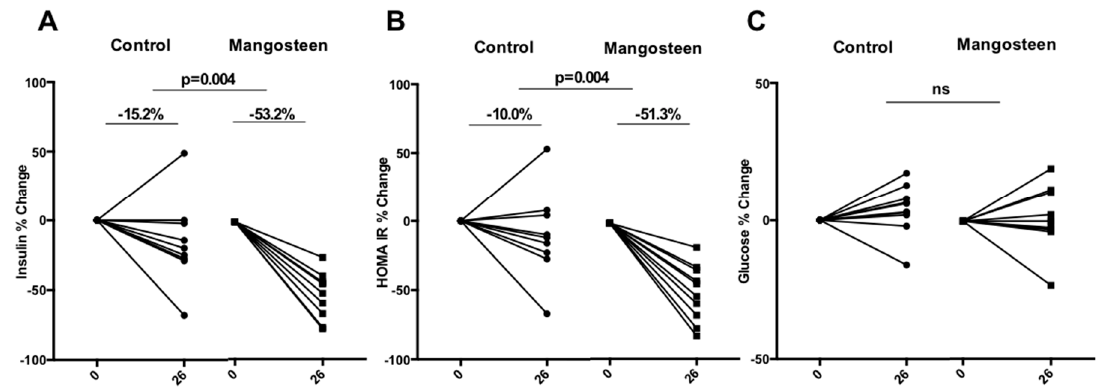
Figure 1. Glucose metabolism markers. ( A ) Insulin levels decreased significantly in the treatment group compared to control at 26 weeks; ( B ) HOMA IR % change went in the same direction in favor of the mangosteen group that showed a frank improvement in insulin resistance; ( C ) glucose levels did not significantly change in any of the studied arms.